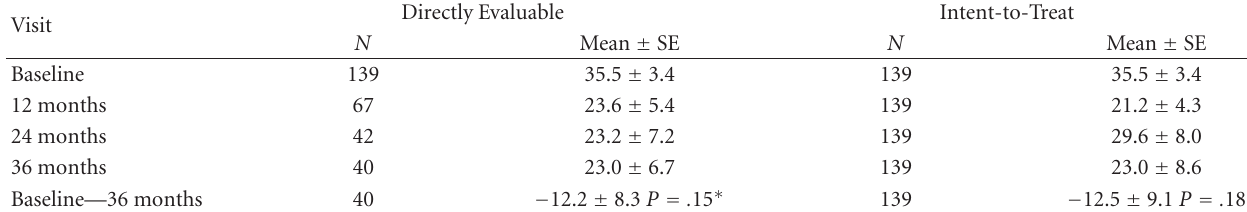
Table 8: Pad weight.